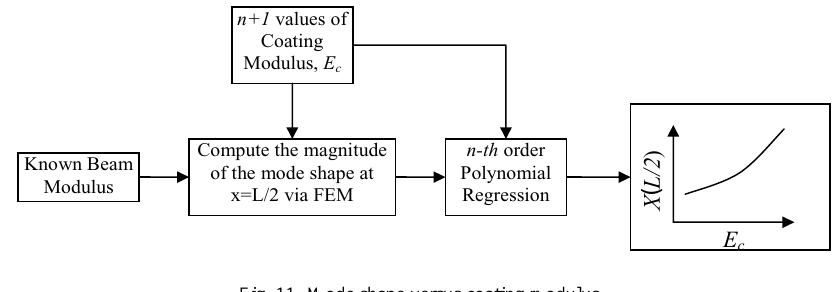
Fig. 11. Mode shape versus coating